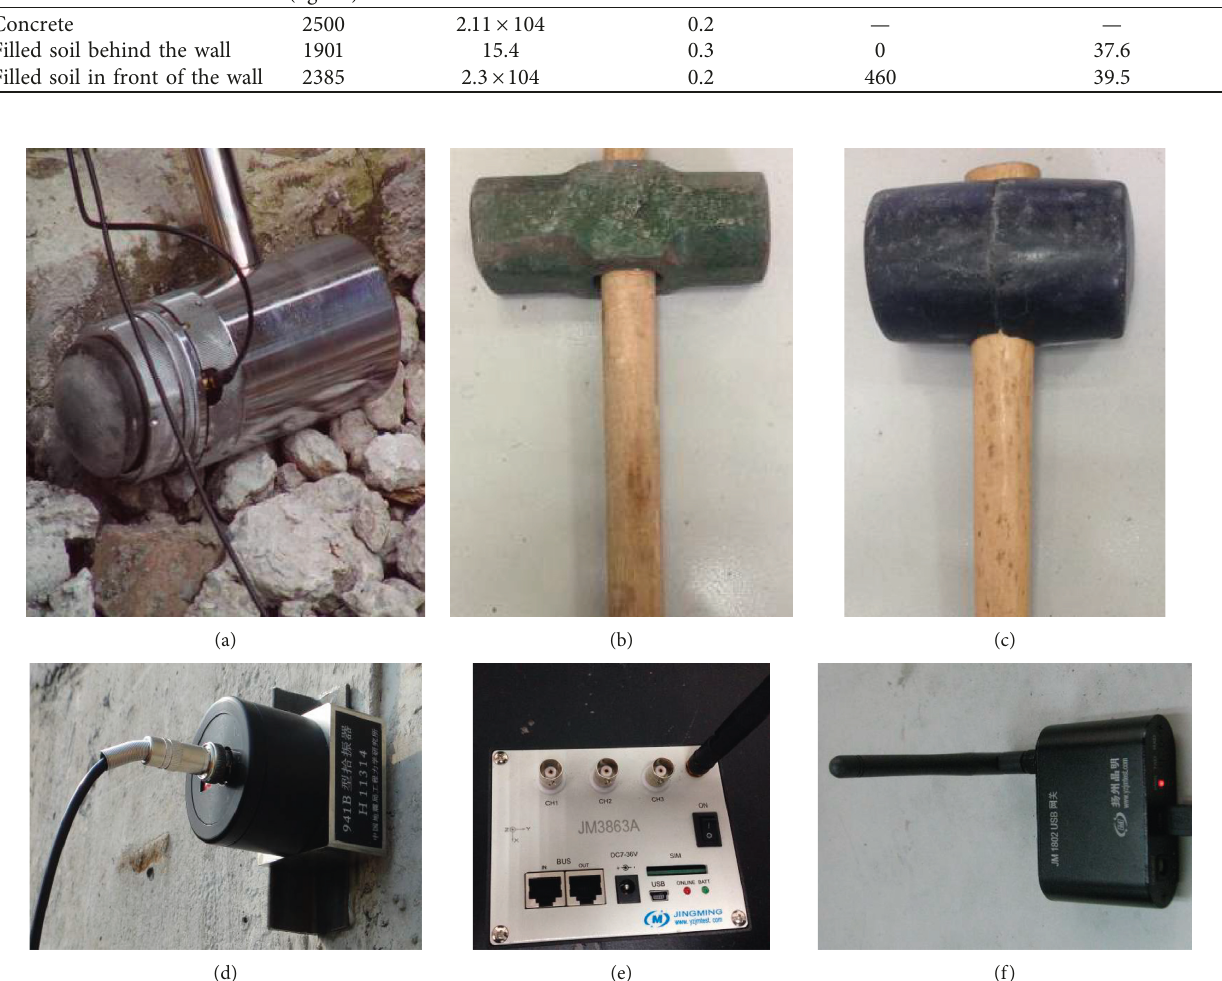
Figure 4: Exciting equipment, sensors, signal collecting system, and signal transmission system of vibration tests. (a) DFC-2 exciting hammer. (b) Common exciting hammer. (c) Rubber exciting hammer. (d) 941B sensor. (e) JM3863A vibration test system. (f) JM1802 wireless